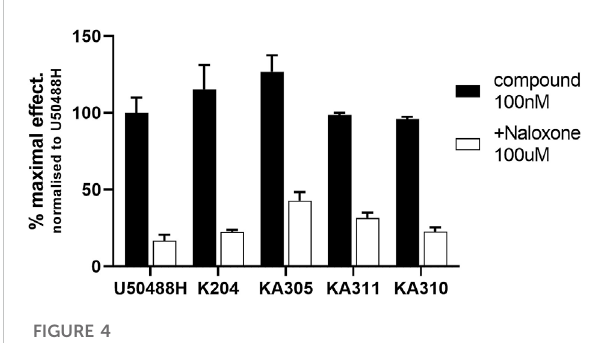
FIGURE 4 Inhibition of cAMP modulation by naloxone. Opioid antagonist naloxone (100 µM) was added to KOP receptor over-expressing HEK293cellspriortostimulatingthemwithleadpeptide(100 nM),and assaying for cAMP activity as described. Naloxone signi fi cantly inhibited peptide activity at KOP receptors, indicating opioid- mediated receptor activity by the peptides. Mean ± SD, n = 3, each in duplicate. * p < 0.05 Student ’ s paired t -test from same compound in absence of naloxone.